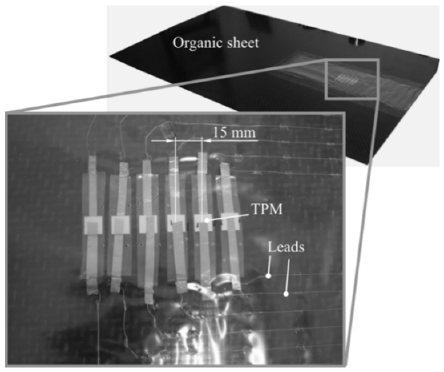
Figure 11. Organic sheet, ePreform with TPM pattern, and conductors (thermally stapled).